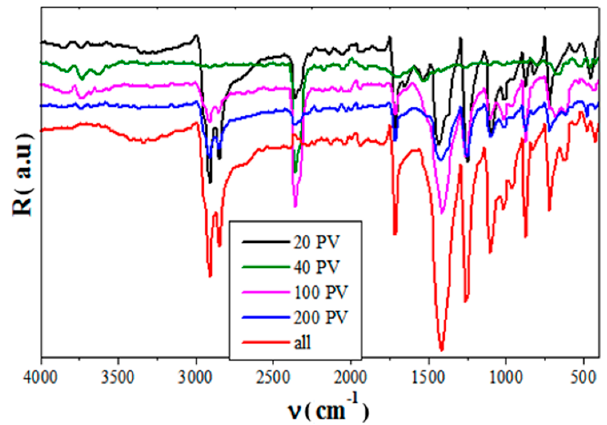
Figure 7. Fourier Transform Infrared Spectroscopy (FTIR) analysis of the 3% PV composite with different Si-PV grain size.